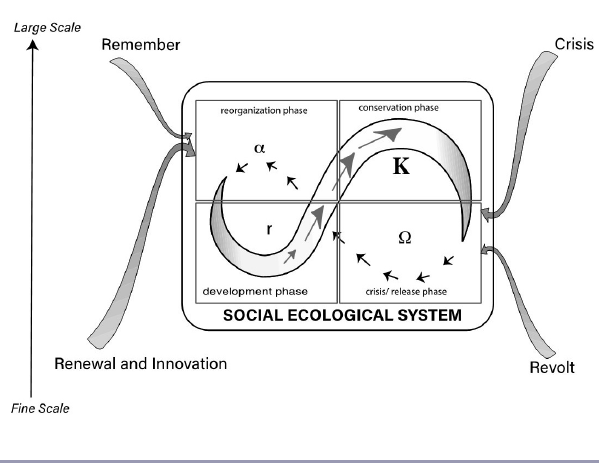
Fig. 1 . The pattern of dynamics in an adaptive cycle, showing how the two phases where change happens (Ω and α ) are influenced by conditions and processes at small and large scales. Adapted from Chaffin and Gunderson